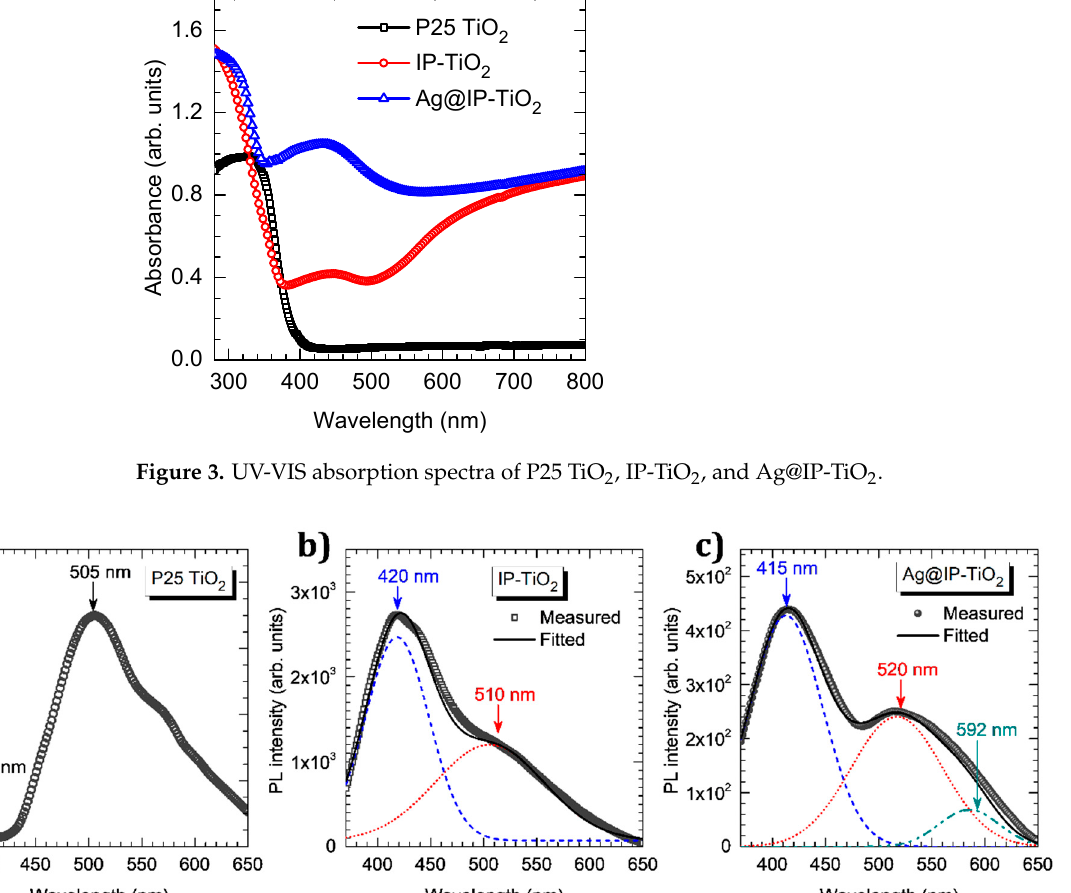
Figure 4. PL spectra of ( a ) P25 TiO 2 , ( b ) IP-TiO 2 , and ( c ) Ag@IP-TiO 2 .